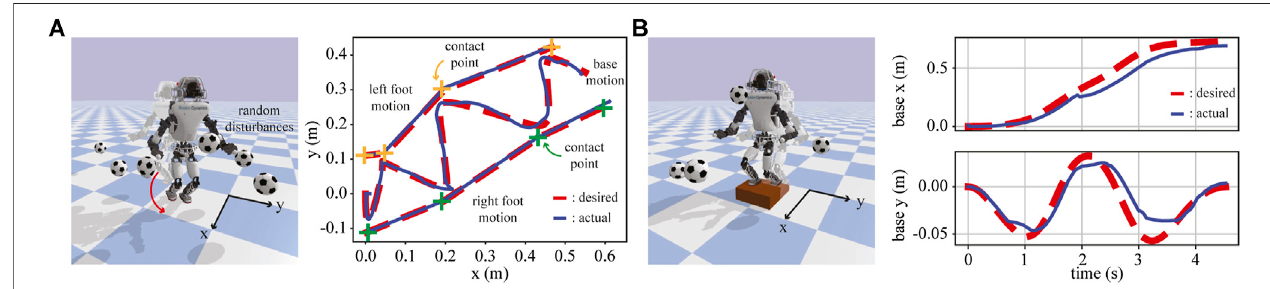
FIGURE 10 | IHWBC stabilizes the robot along the solution trajectory computed by TOWR+ under unknown disturbances in the physics simulator. (A) ATLAS walking with a top view of its walking trajectories, and (B) ATLAS climbing a stair with its base trajectories being illustrated.